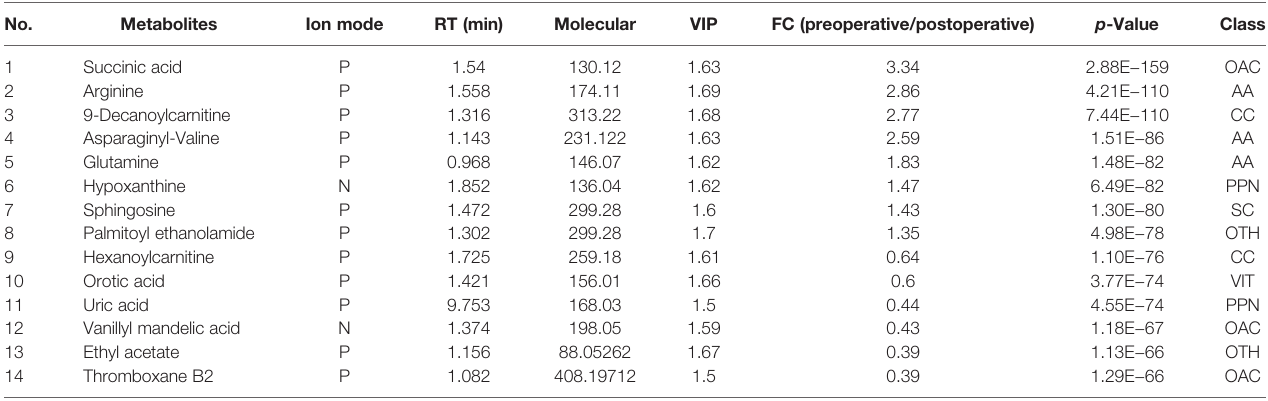
TABLE 1 | Statistical analysis of potential metabolic biomarkers.